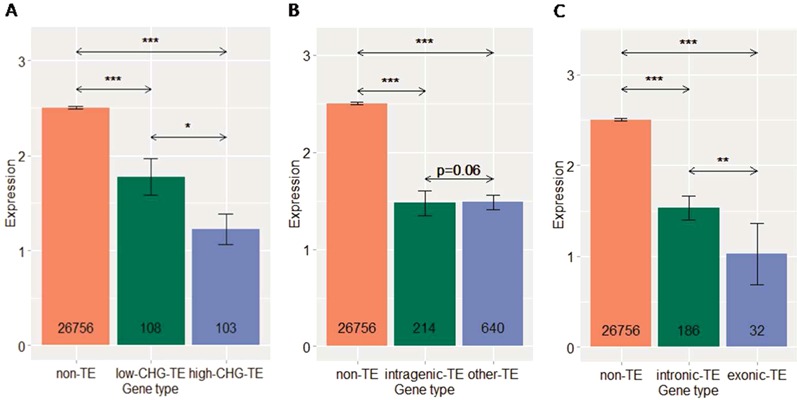
Negative impact of intragenic TEs and their methylation on gene expression (log2(RPKM + 1)) in A. thaliana. (A) Expression of genes containing high-CHG-methylated TEs, low-CHG-methylated TEs and genes without TE insertions. (B) Expression of genes containing intragenic TEs, overlapped with other TEs and genes without TE insertions. (C) Expression of genes harboring exonic TEs and intronic TEs, and genes without TE insertions. (*), (**), (***) correspond to P < 0.05, 0.005 and 0.0005, the MWU test, respectively.